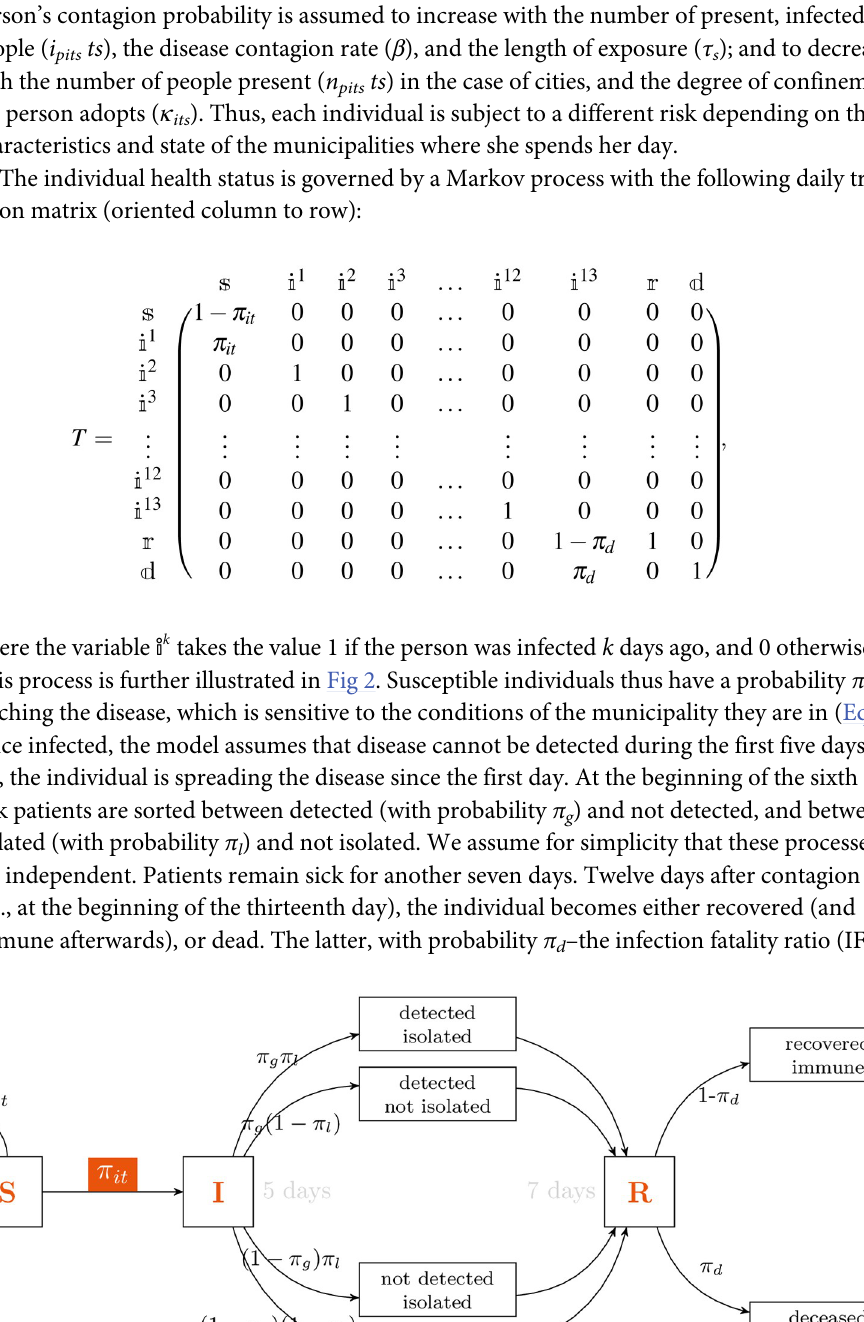
Fig 2. The SIR model. Succeptible individuals become Infected with probability π and/or isolated, after which they are Removed (meaning they recover or die).